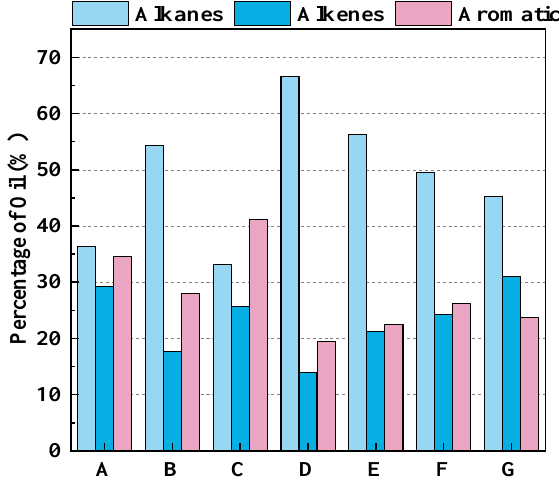
Figure 4. Content of alkanes, alkenes, and aromatics in pyrolysis oils for Groups A–G. The ignition loss and calorific value of pyrolytic coke are shown in Table 4. When HR and ISW1 co-pyrolyzed, the lowest coke ignition loss rate was 16.2% (C), which was due to the further pyrolysis of coke at a higher temperature. The highest ignition loss rate was 34.1%, because of the low temperature. At a low temperature, coke was the main pyrolytic product, and carbon was mainly found in solid form. When HR and ISW2 co-pyrolyzed, the ignition loss was 41.9%, which was much higher than that of co-pyrolyzed HR and ISW1. Compared with HR pyrolysis alone, co-pyrolyzed coke had a higher calorific value. Therefore, co-pyrolyzed coke could be recycled, which is conducive to improving energy utilization. Table 4. Ignition loss rate and calorific value of coke.